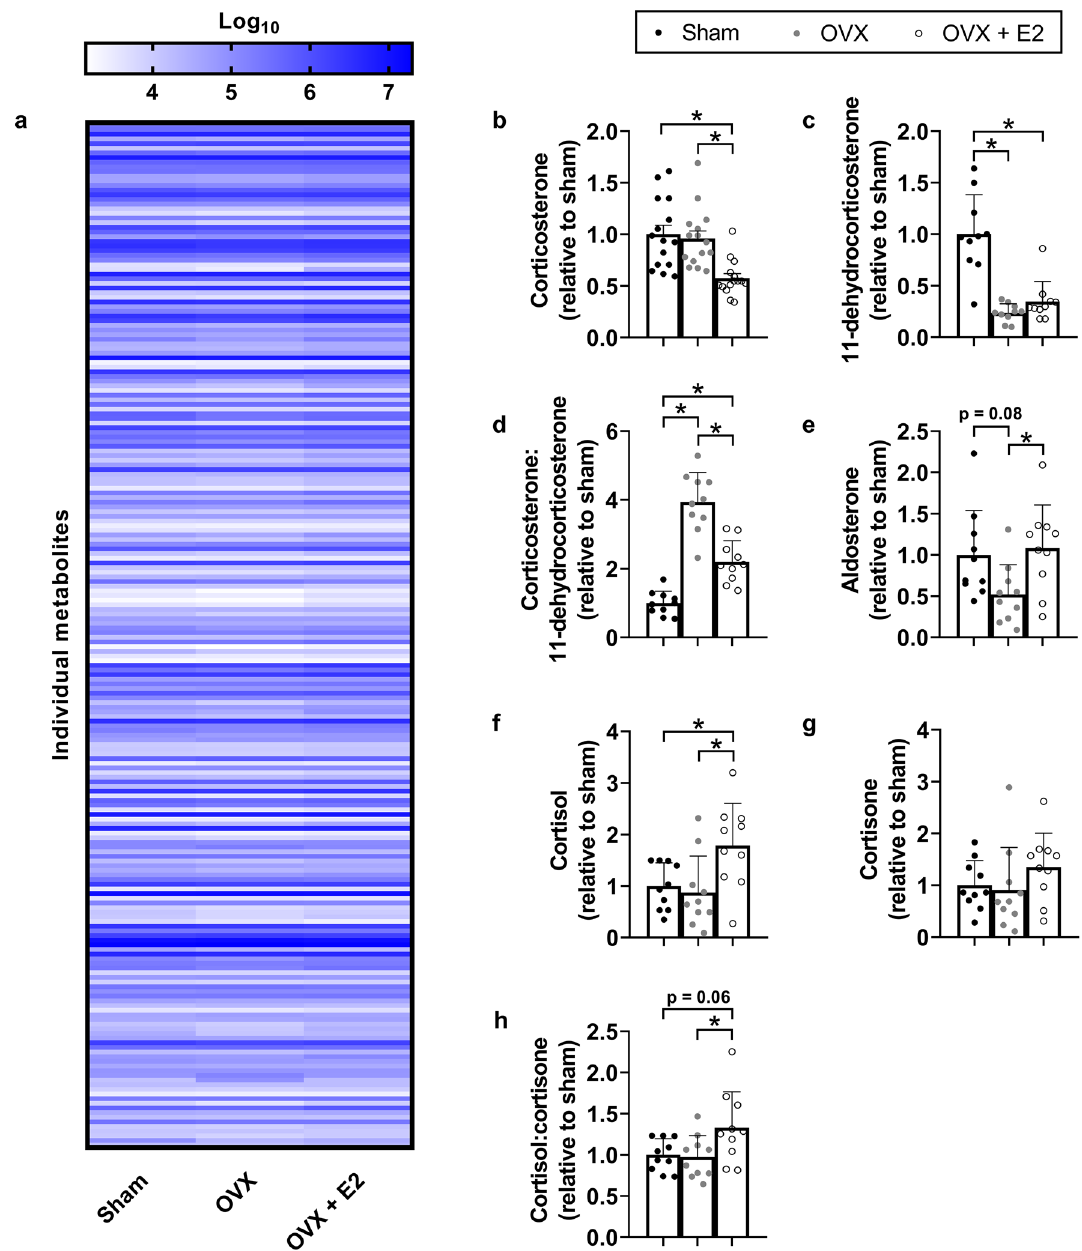
Figure 7. Ovariectomy/oestrogen differentially regulate HPA and RAAS activity in female mdx mice in response to stress. ( a ) Metabolomic screen, ( b ) corticosterone, ( c ) 11-dehydrocorticosterone, ( d ) corticosterone:11-dehydrocorticosterone, ( e ) aldosterone, ( f ) cortisol, ( g ) cortisone and ( h ) cortisol:cortisone in serum of sham, OVX and OVX + E2 female mdx mice following a 30 s scruff-restraint. N = 10/group. All data were analysed by one-way ANOVA with Tukey’s post-hoc analysis except 11-dehydrocorticosterone and cortisone, which were analysed by Kruskal–Wallis test with Dunn’s post‑hoc analysis. Data are mean ± SD. *p <